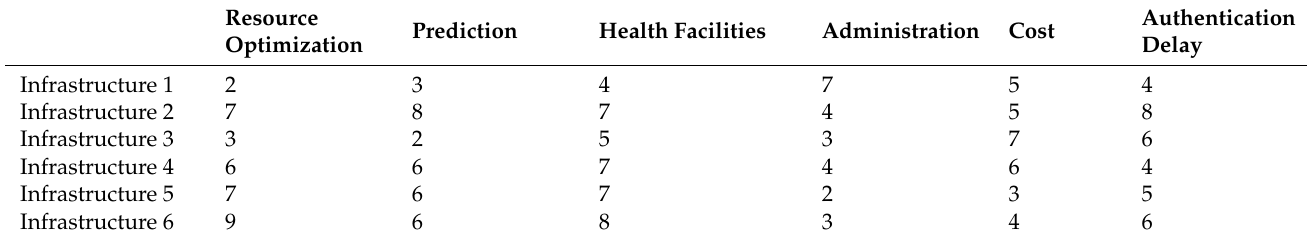
Table 6. Decision Matrix.